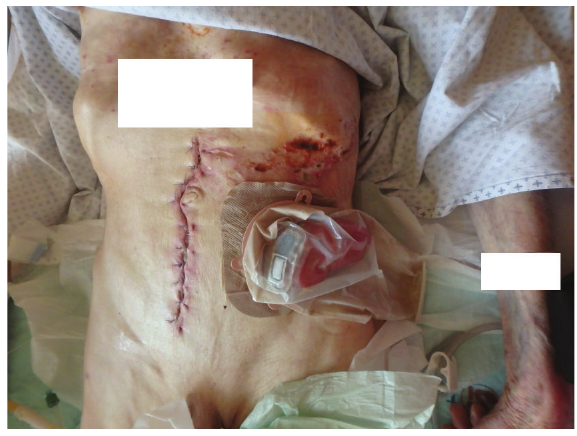
Figure 7: Operation site after operation with laparotomy scar and artificial anus (anus